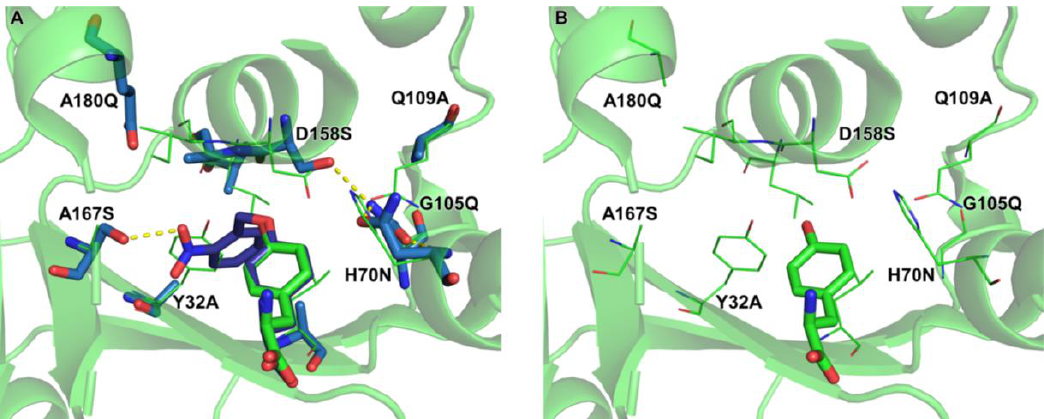
Figure 5. ( A ) ONBYRS-1 active site modeling with bound ONBY substrate. Mutations relative to wild type Mj TyrRS (PDB ID 1J1U, residues as thin lines) are indicated. The original orientation of the wild type substrate Tyr is shown in green, the similarly oriented ONBY is shown in purple. H bonds between S167 and the ONB nitro group as well as the H bond network between N70, Q105 and S158 are shown as dashed yellow lines. ( B ) Wild type Mj TyrRS structure for comparison, keeping ONBYRS-1 mutation sites indicated.